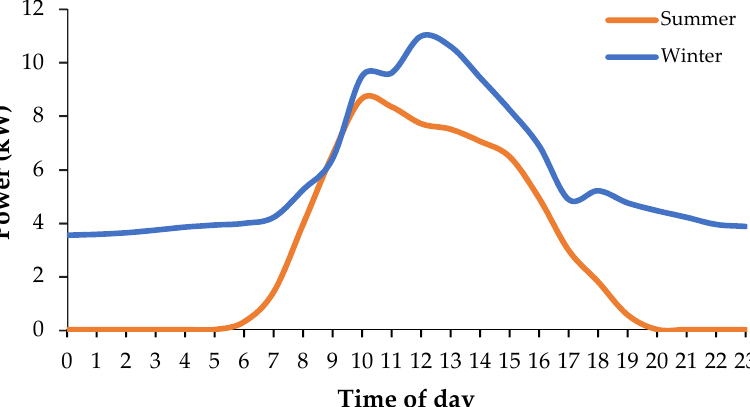
Figure 8. Daily profile of power that is made available in winter and summer by replacing an existing house with a low-energy solar house.